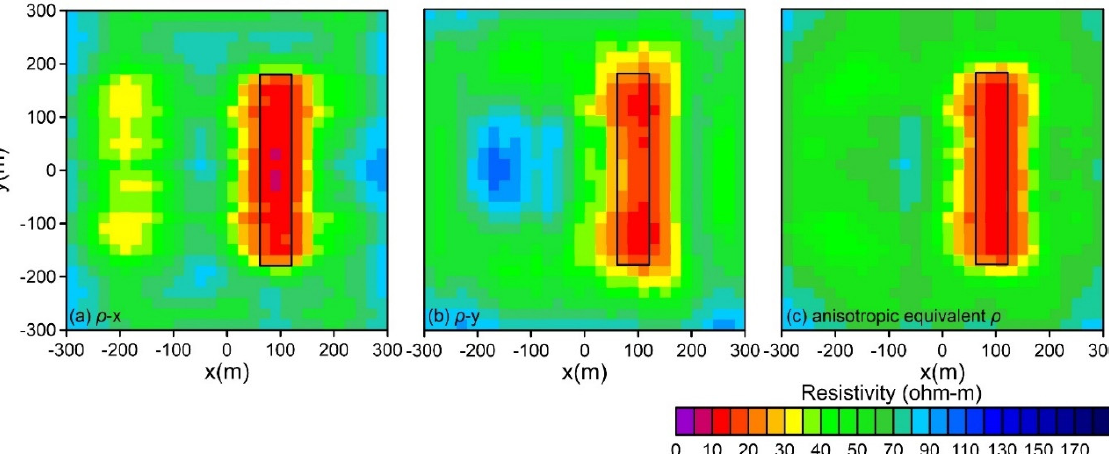
Figure 8. Horizontal slices of anisotropic inversion results for the model in Figure 5. ( a ) and ( b ) show the inversion results in x and y -directions; ( c ) shows the equivalent resistivity ρ h (all horizontal slices are displayed at z = 44 m).